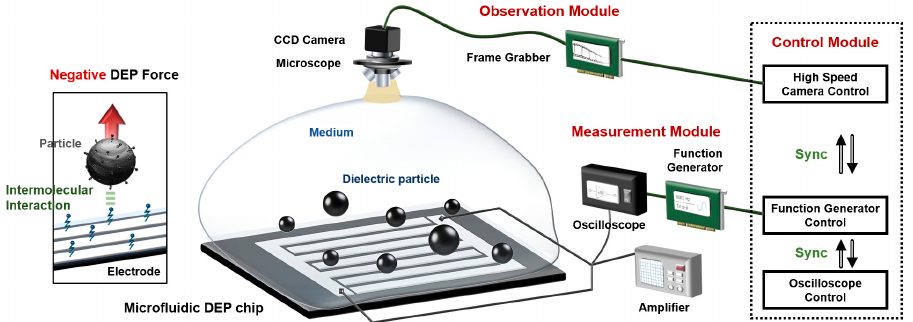
Figure 1. System diagram of the dielectrophoretic (DEP) tweezers-based force spectroscopy (DFS) system. The DFS system consists of three modules: an observation module, a measurement module, and a control module. In the control module, three components manipulate each device in the observation and measurement modules with synchronization.